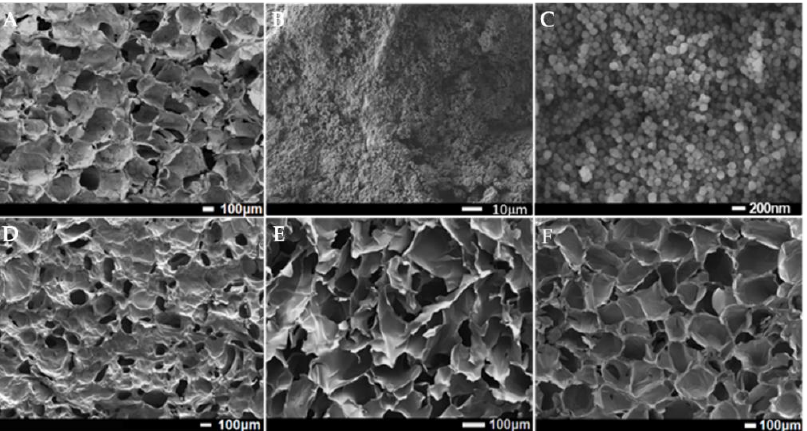
Figure 1. SEM images of surface morphology of F-CS aerogel ( A – C ) under different magnifications, surface morphology of CS aerogel ( D ), cross-sectional morphologies of CS ( E ), and F-CS aerogel ( F ).